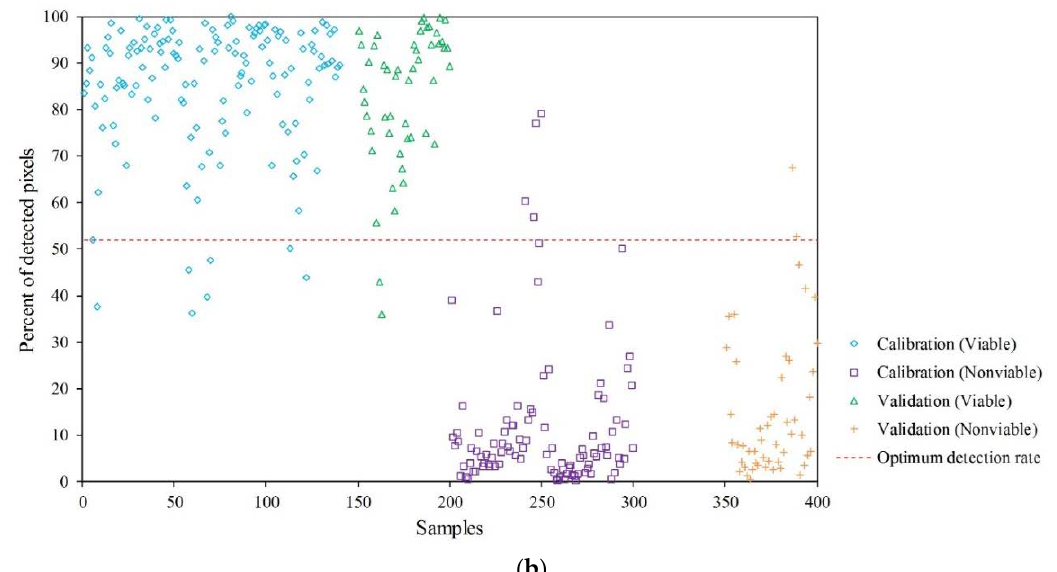
Figure 8. Graphical representation of results of image-based classification of viability of soybean seeds in the calibration and validation sets of whole spectral data ( a ) and VIP-selected variables ( b ) using optimum detection rate.